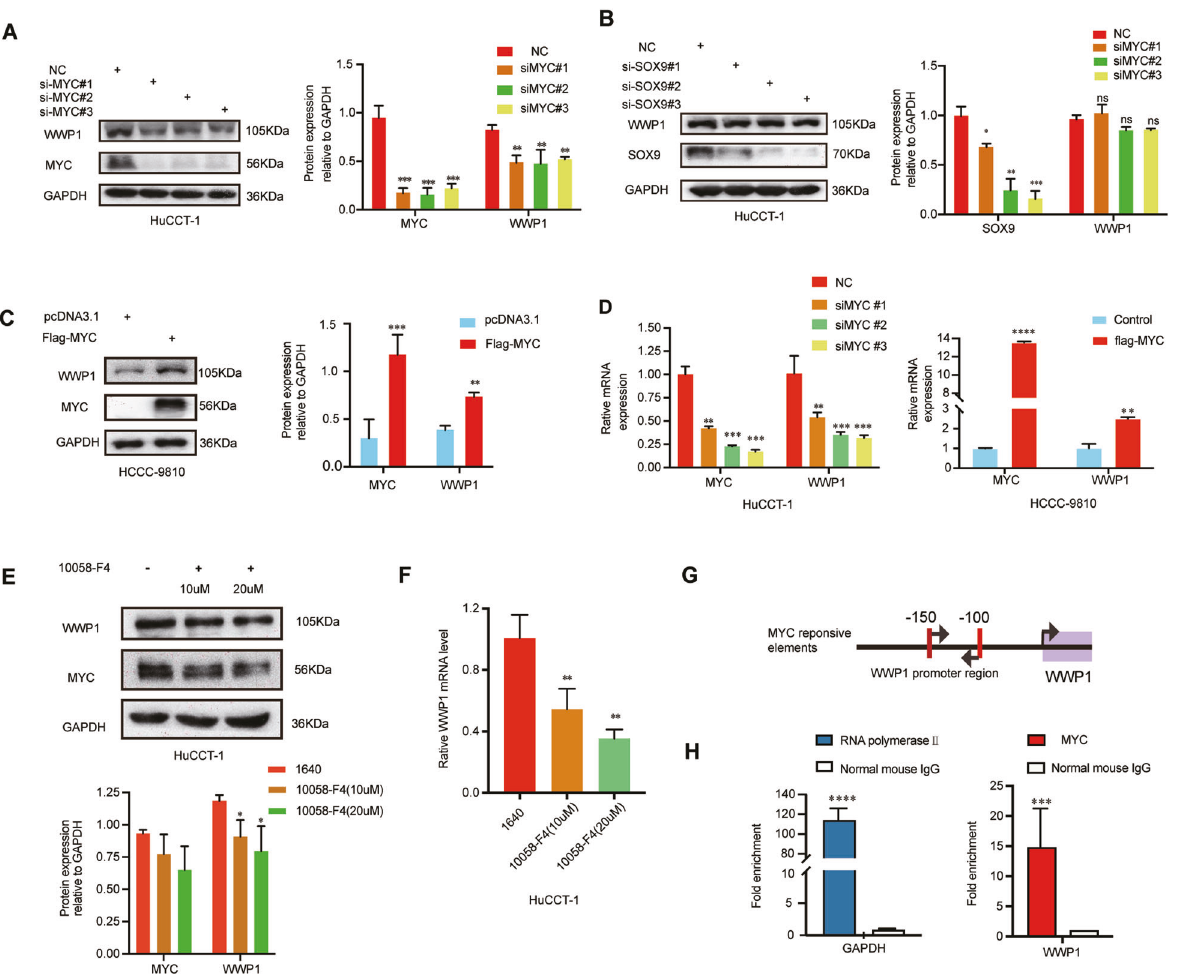
Fig. 5 MYC transactivated WWP1 gene expression in ICC cells. A The protein level of WWP1 in HuCCT1 cells with MYC knockdown was evaluated by western blotting, n = 3 B The protein level of WWP1 in HuCCT1 cells with SOX-9 knockdown was determined by western blotting, n = 3. C The protein level of WWP1 in HCCC-9810 cells with MYC overexpression was evaluated by western blotting, n = 3. D The mRNA levels of WWP1 in HuCCT1 cells with MYC knockdown and HCCC-9810 cells with MYC overexpression were evaluated by qPCR, n = 3. E The protein level of WWP1 in HuCCT1 cells treated with 10058-F4, a speci fi c c-MYC inhibitor, in the indicated concentrations for 24 h was evaluated by western blotting, n = 3. F The mRNA level of WWP1 in HuCCT1 cells treated with 10058-F4, a speci fi c c-MYC inhibitor, in the indicated concentrations for 24 h were evaluated by qPCR, n = 3. G Schematic representation of MYC responsive elements in the promoter region of WWP1. H Chromatin level of MYC at the promoter region of WWP1 was detected in HuCCT1 cells. Fold enrichment of MYC relative